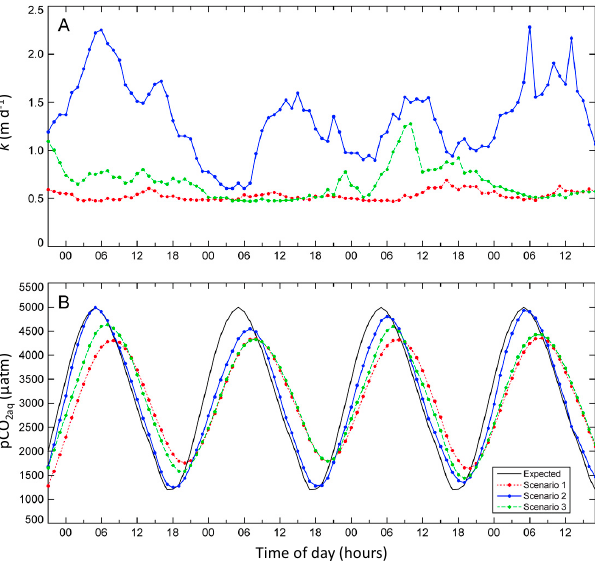
Figure 4. Example where k values (piston velocity; see text) were calculated from wind speed according to (Cole and Caraco, 1998) for three real scenarios with different diel variability (a) , and then used to model the diel pattern in p CO 2aq chambers of the type we used compared to the expected cases based on instantaneous p CO 2aq levels (b) . The expected case is hypothetical but inspired by levels found for a pond with large diel variability (Natchimuthu et al.,